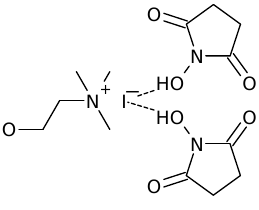
Figure 6. Structure of DES obtained from choline chloride and NBS in a molar ratio of 1:2. Soon after, the same researchers tested a series of DESs comprising tetra- n -butylphosphonium bromide (TBPB) as HBA and different aromatic substrates (phenol, aminophenol (AP), aniline and benzoic acid) as HBDs in the synthesis of cyclic carbonates from CO 2 and epoxides [40]. They found that the TBPB:3-AP deep eutectic solvent was the most excellent catalyst, giving propylene carbonate in high yield (99%) and selectivity (96%) in fairly mild reaction conditions (80 ◦ C, 1 MPa and only 1 h reaction time). A